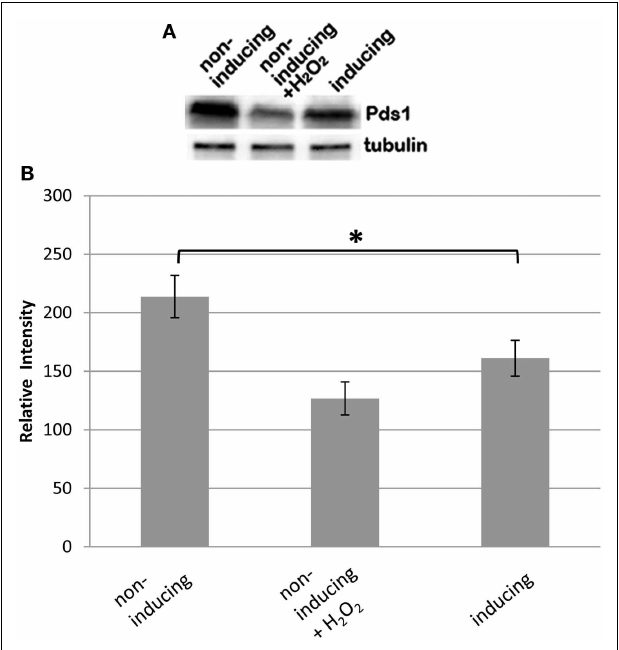
FIGURE 5 | Bir1 deletion causes the degradation of the anaphase inhibitor Pds1. BIR1-degron cells were grown inYPDCu (24˚C) to early phase. Four millimolars of H 2 O 2 was added for 1˚h (middle lane), or cells were transferred toYPG (37˚C) for 1˚h. (A) Western blot analysis of Pds1 degradation and (B) quantitative analysis of theWestern blot ( n = 3). β -Tubulin was used as control. ∗ P <